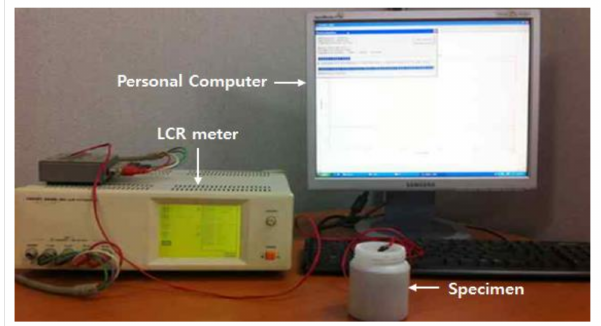
Figure 3. Experimental setup for EMI-based monitoring of cement paste